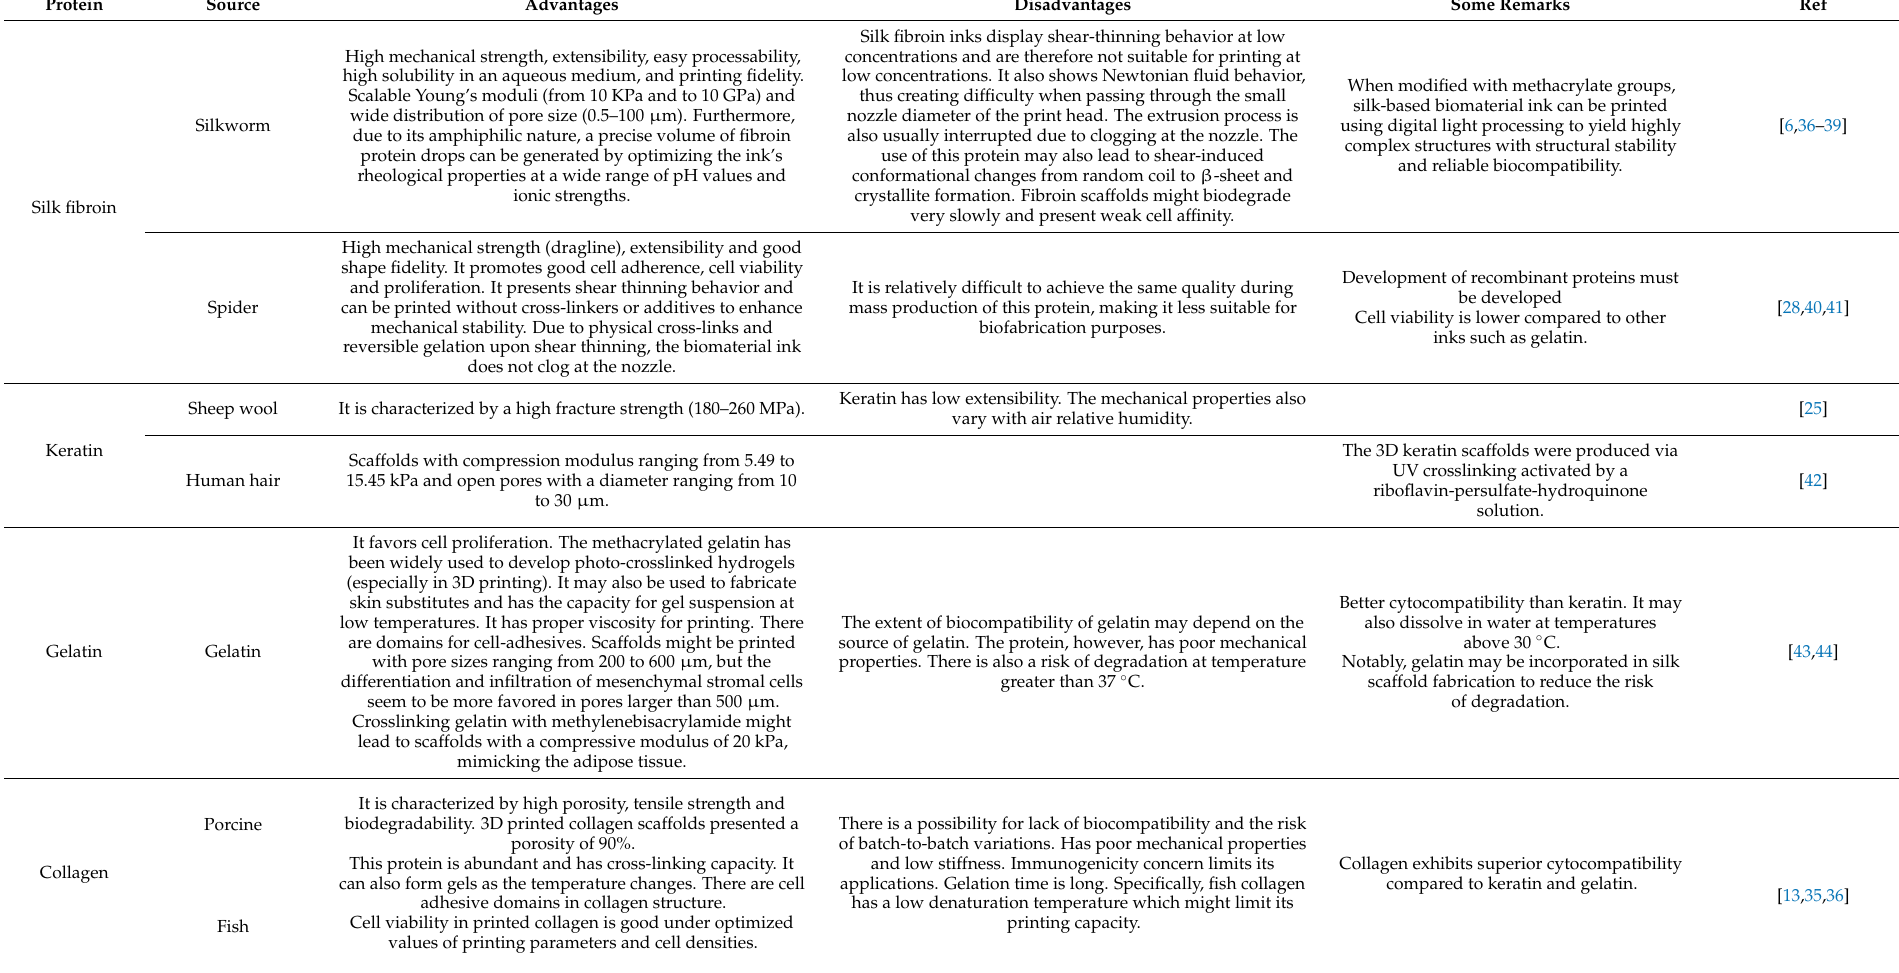
Table 1. Summary of advantages and disadvantages of some protein-based materials with regards to printing and applicability in tissue